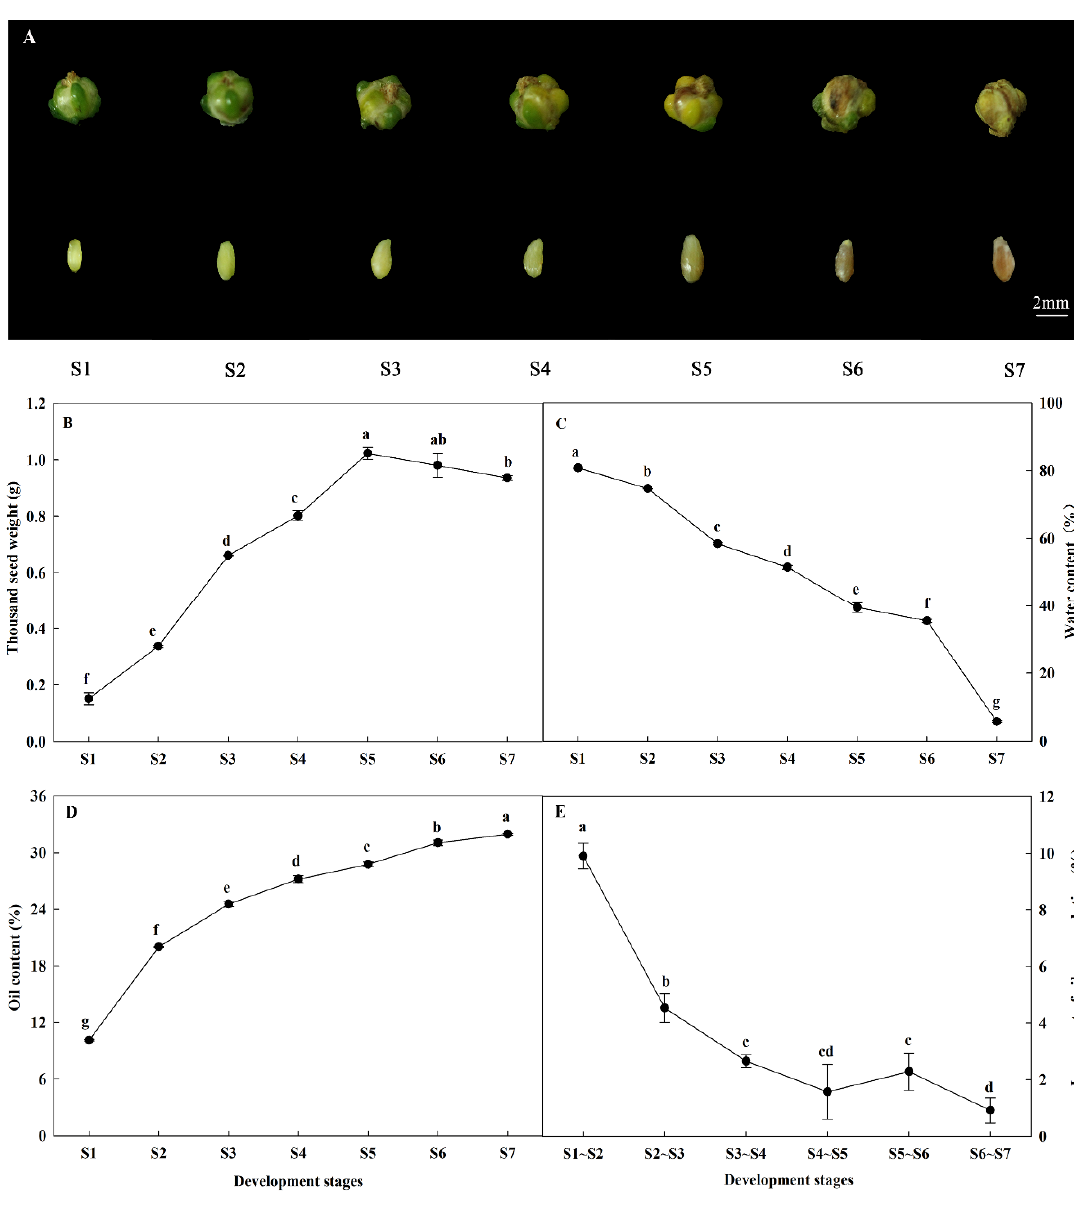
Figure 1. Morphological characteristics and oil content during seed development stages. ( A ) morphological characteristics; ( B ) thousand seed weight; ( C ) water content; ( D ) oil content; and ( E ) increment of oil accumulation. Note: S1~S7 represent 10, 20, 30, 40, 50, 60, and 70 days after flowering, respectively. The upper row represents the pods, and the lower row represents the seeds. Increment of oil accumulation = difference in oil content of two adjacent stages. Different lowercase letters indicate significant differences at p < 0.01.